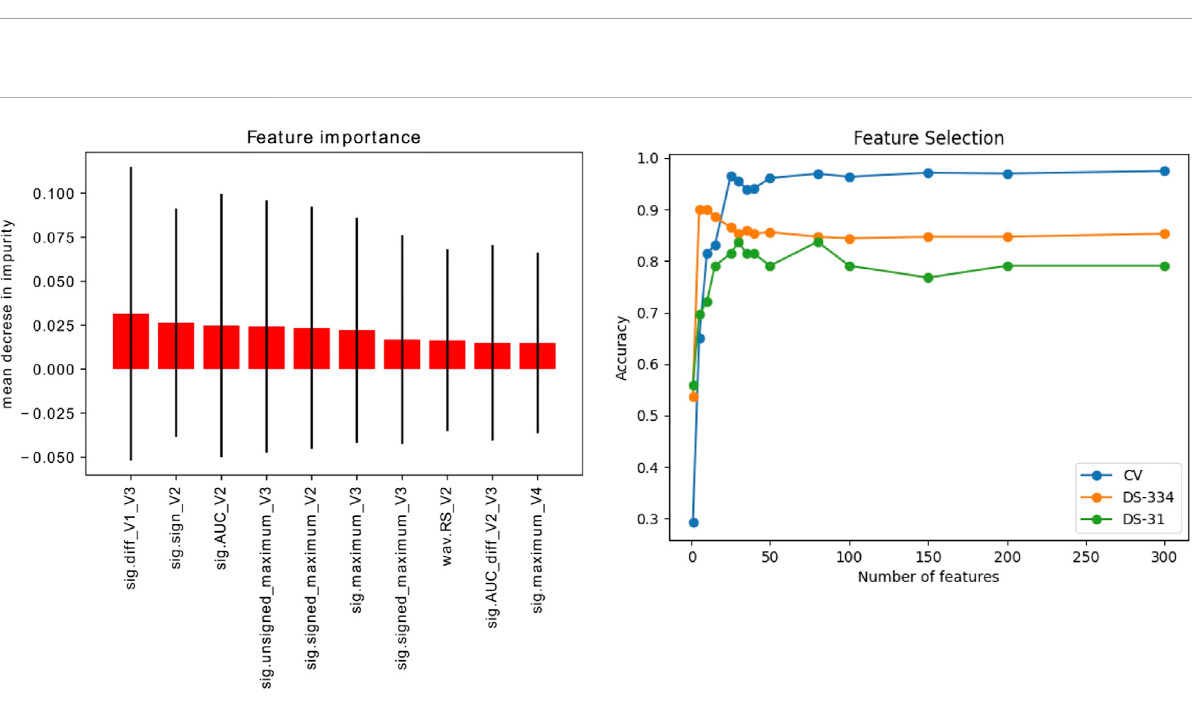
FIGURE 8 Left: Ranking of the 10 most important signal features (out of 356) for signal classi fi cation, extracted using the extra-trees classi fi er method. Right: Evolution of the accuracy scores vs. the number of features used for training. The accuracy was evaluated in the simulated signals through a cross validation (CV) process and in the clinical datasets (DS-334 and